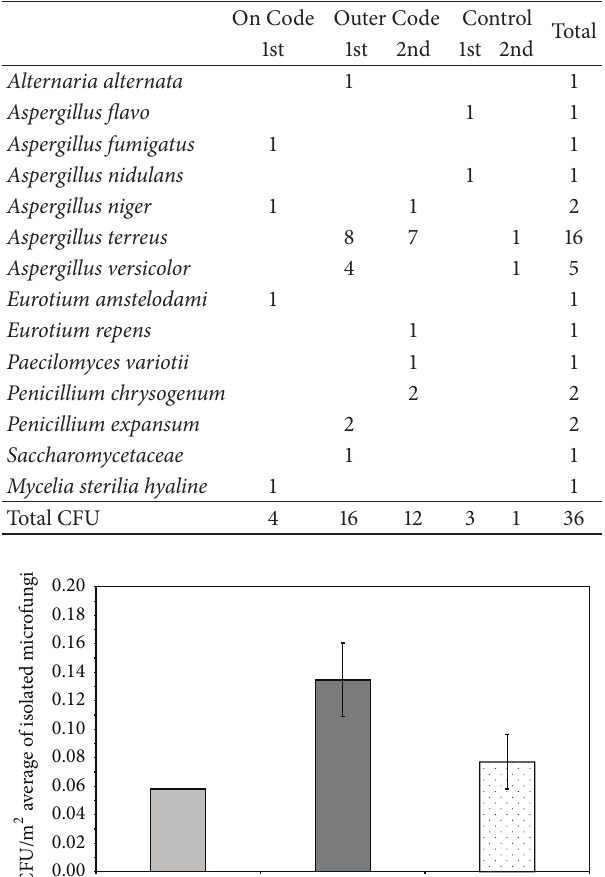
Table 1: Species and CFU of isolated microfungi from sampling campaigns (1st and 2nd) on Code, outer Code, and control.